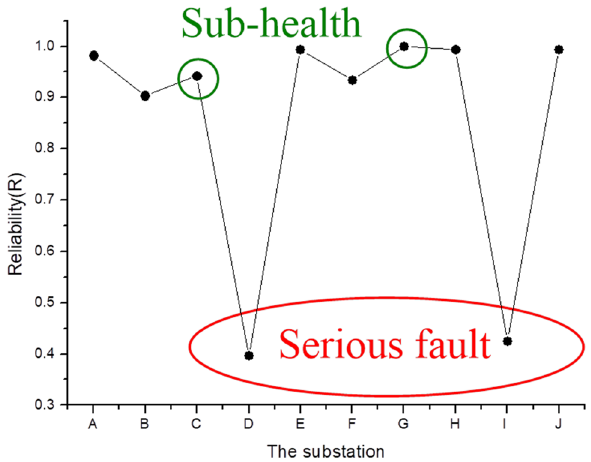
Figure 2. The calculated reliabilities of each